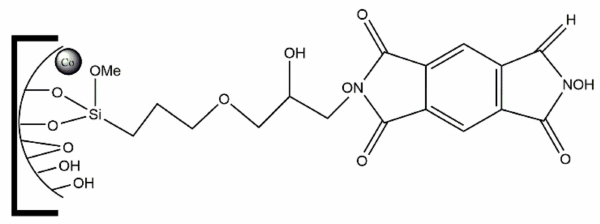
Figure 27. Structure of NDHPI-epoxy/Co-SBA-15 [170].